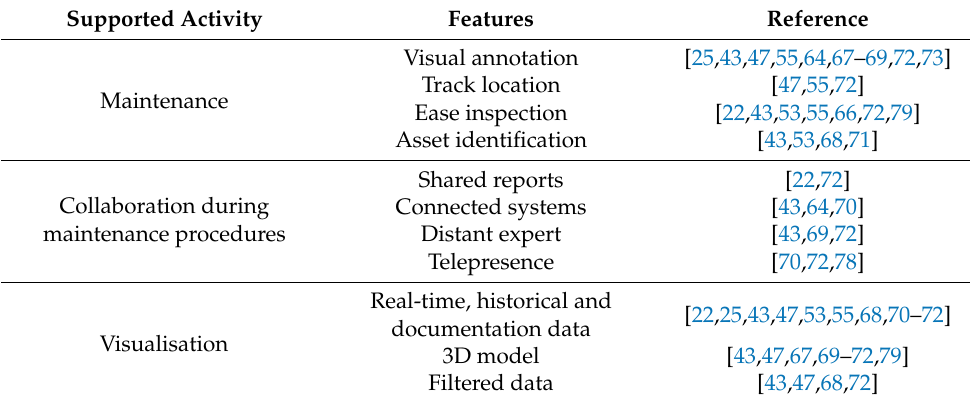
Table 7. Categorical review of maintenance-related papers using DT and XR technologies with/without BIM. Supported Activity